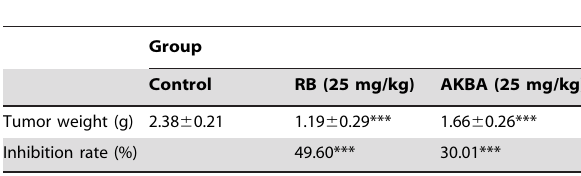
Table 1. Effect of RB on tumor growth (n=6, mean 6 S.D.)